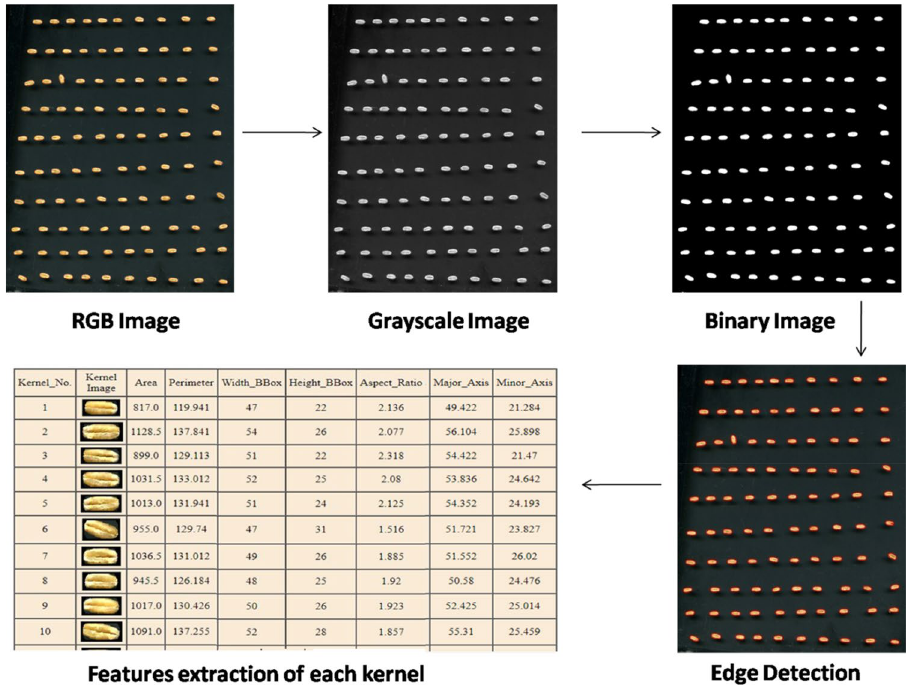
Figure 2. Flow diagram for features extraction from acquired images.